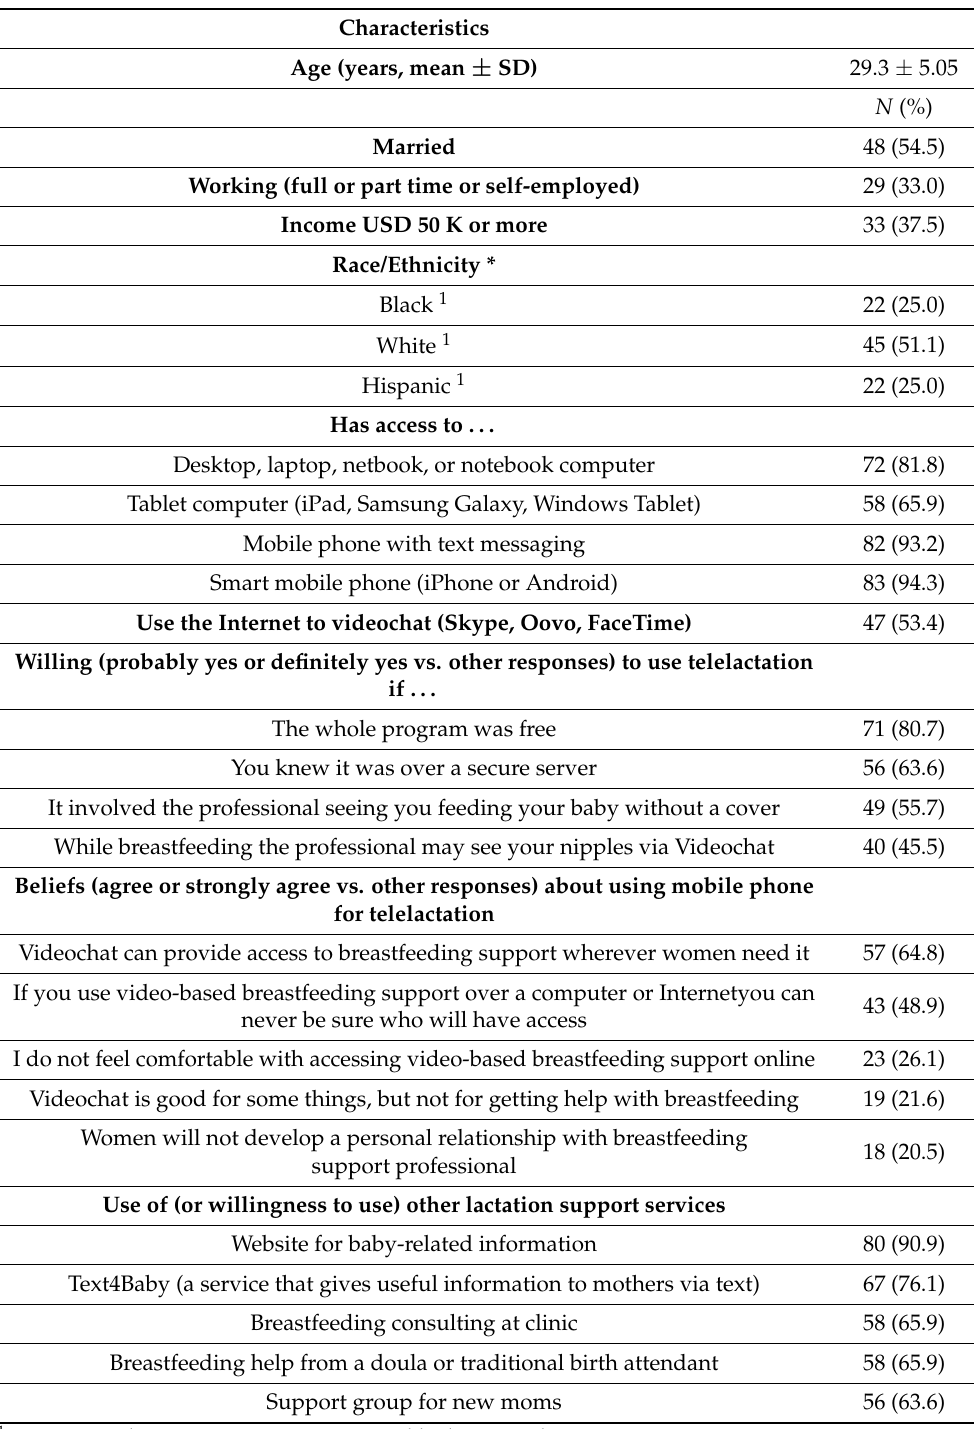
Table 2. Characteristics of the sample ( N =